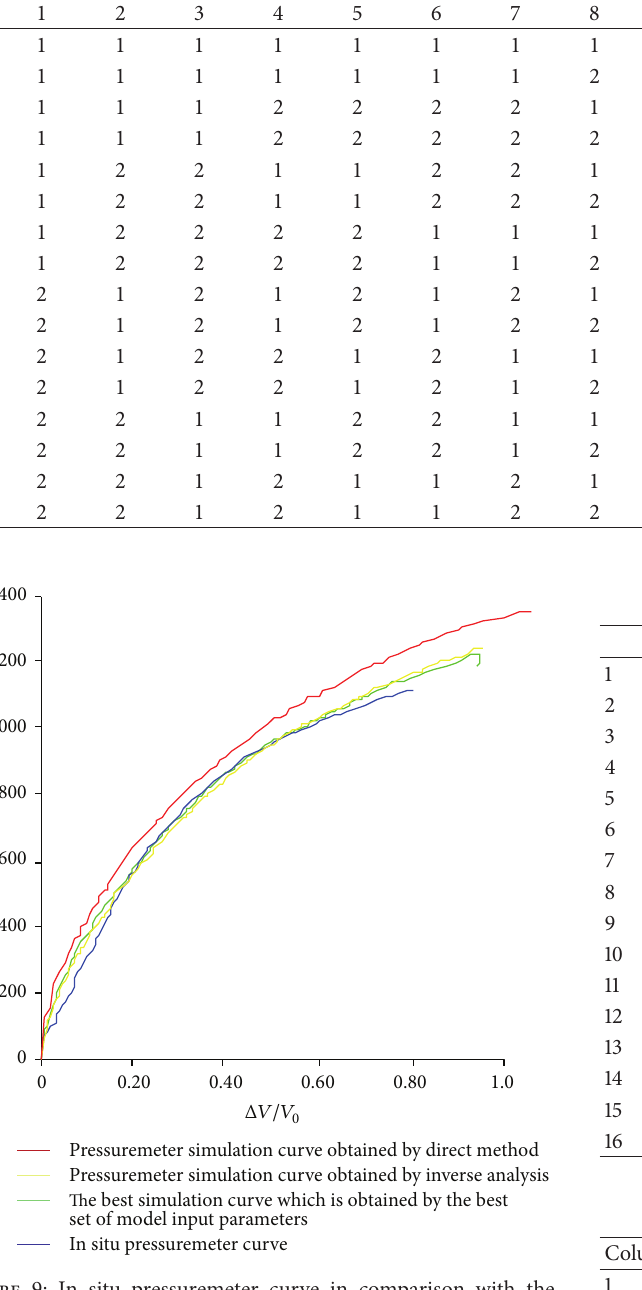
Figure 9: In situ pressuremeter curve in comparison with the best simulation curve, pressuremeter simulation curve obtained by inverse analysis (performed after sensitivity analysis), and pres- suremeter simulation curve obtained by substituting field attained- parameters (direct method).